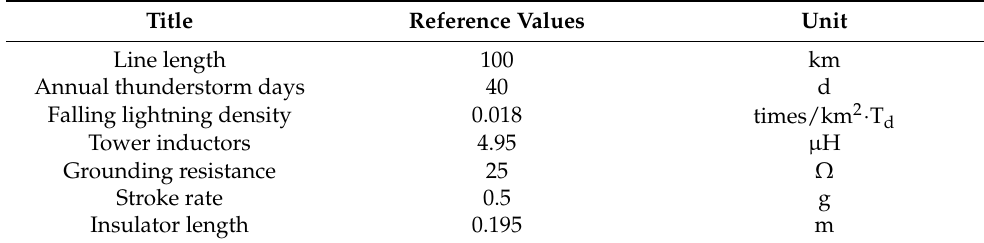
Table 2. The 10 kV overhead distribution line